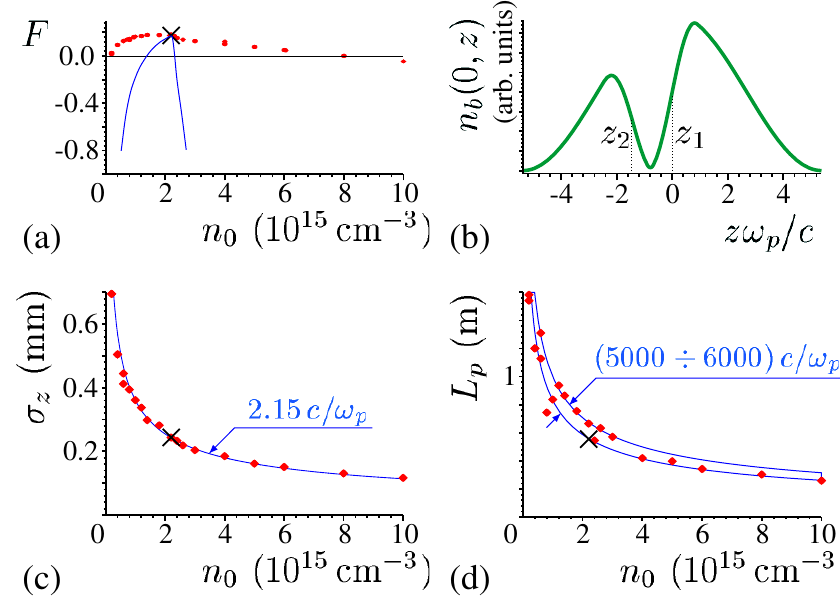
(cid:3) (cid:1) const (line); (b) ; (cid:1) ; z ; z ; L r z p 1 2